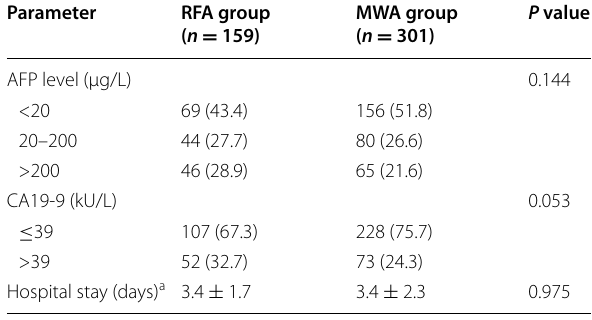
patients with hepatocellular carcinoma (HCC)